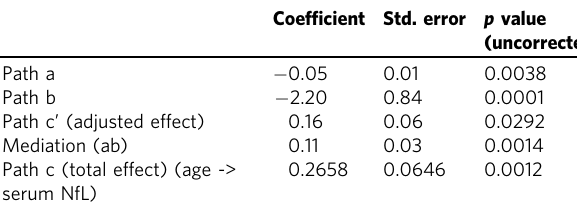
Table 2 Statistics for mediation analysis between age and serum NfL with GSP feature from right isthmus cingulate as mediator variable for HC